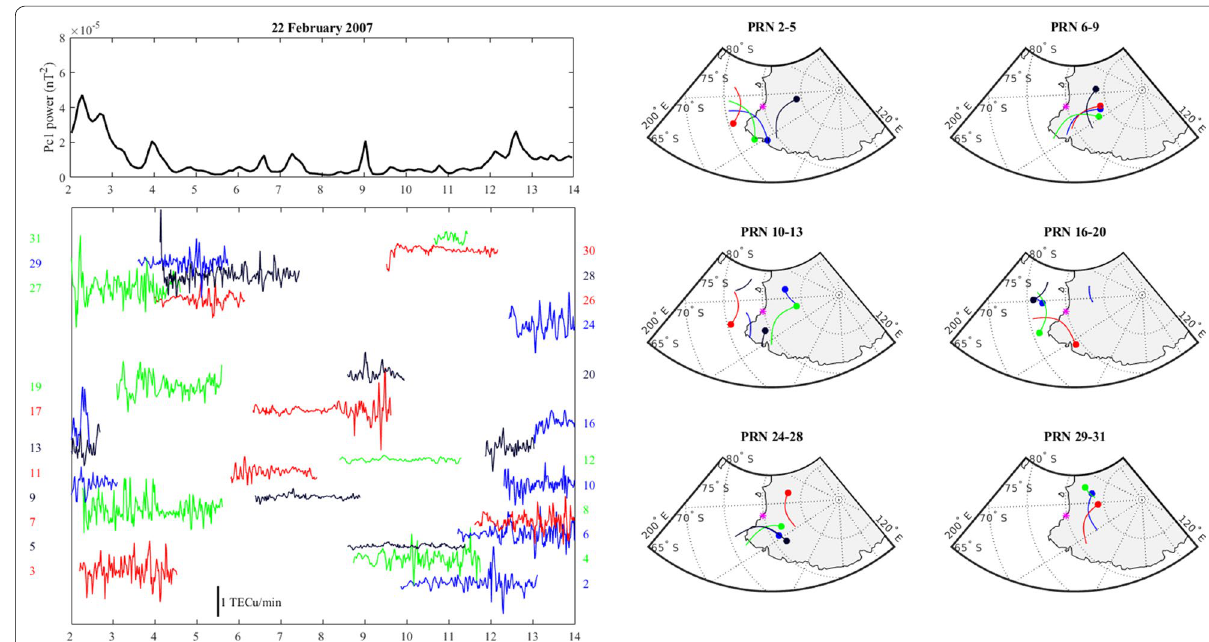
Fig. 3 The Pc1 pulsation power (left, upper panel) and the ROT time series from different satellites over MZS (left, bottom panel) on 22 February 2007. On the right corresponding ionospheric pierce points of satellites are plotted between 65°–80°S and 120°–200°E geographic coordinates; CGM meridians and parallels are shown as dotted lines; filled circles mark the start times; pink star represents